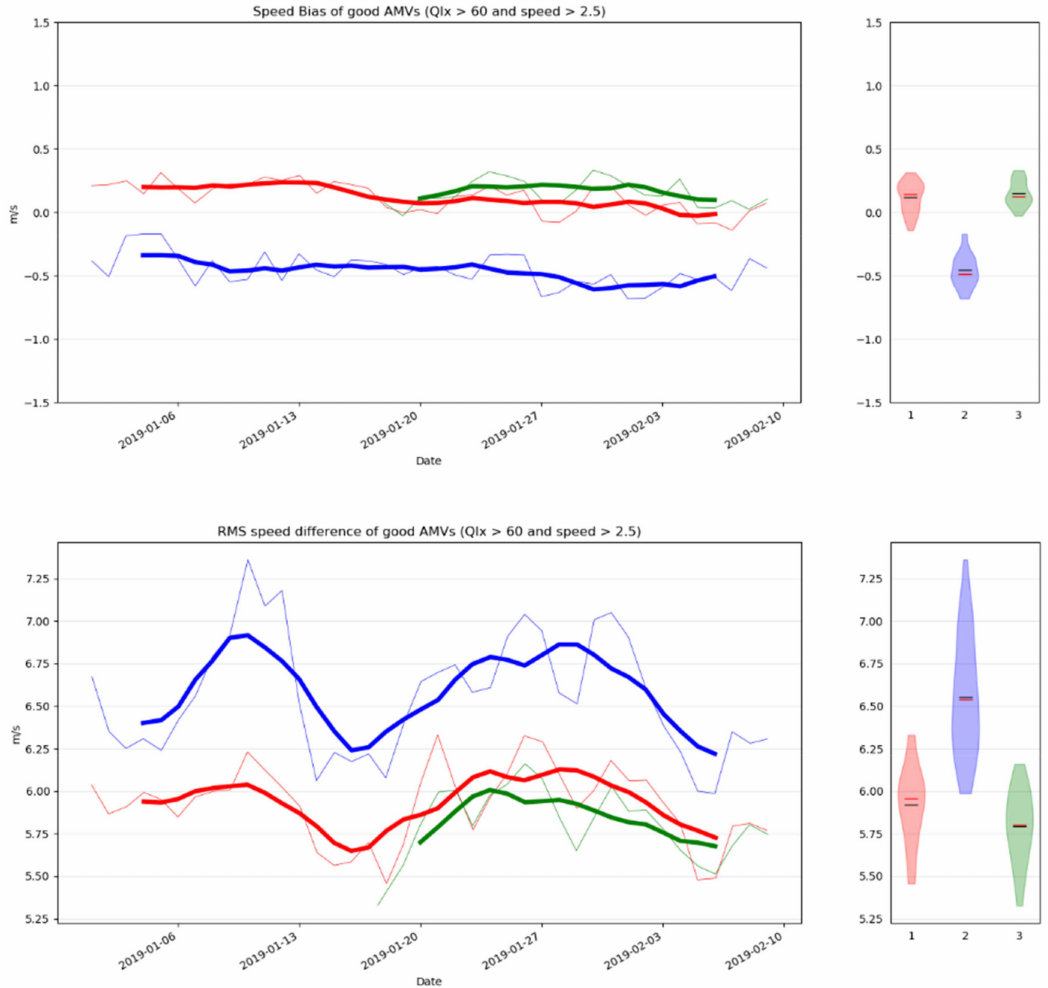
Figure 4. AMV speed biases (top) and root mean square (RMS) (bottom) against forecast for the dual Metop wind products extracted from Metop-A (red), Metop-B (blue) and Metop-C (green) over the northern region for January 2019. Only AMVs with a quality index larger than 60 and a speed larger than 2.5 m / s have been considered in the statistics. Operational change including Metop-C occurred the 17th